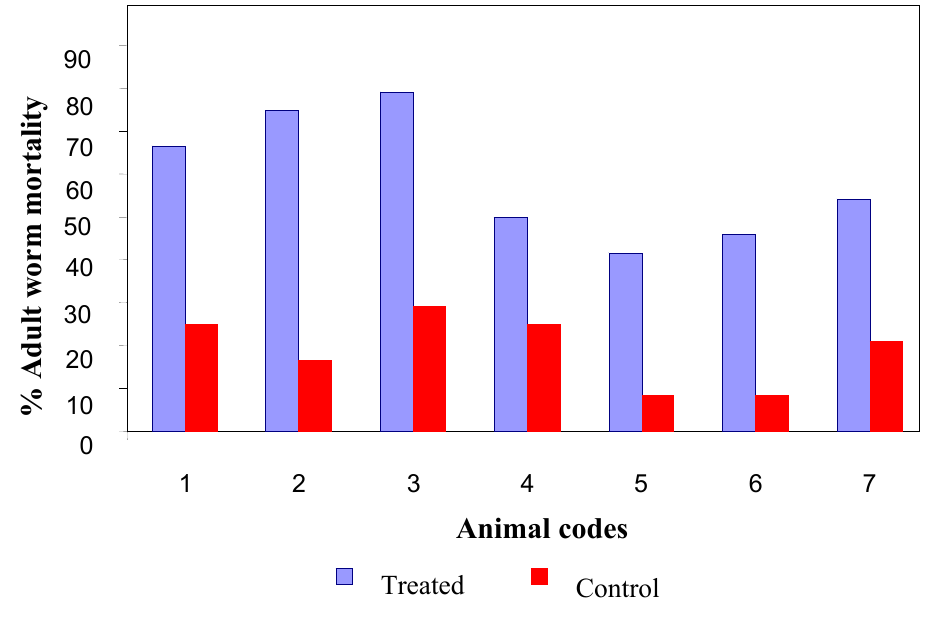
Figure 2. Adult worm mortality in treated and control animals.